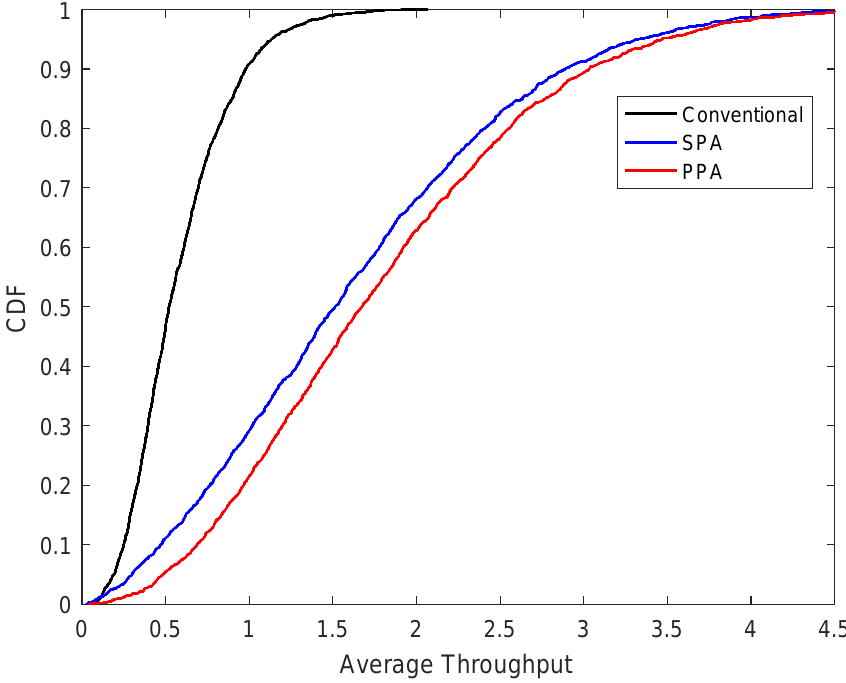
Figure 6. CDF of the average uplink rate per user when M = 64 using a ZF